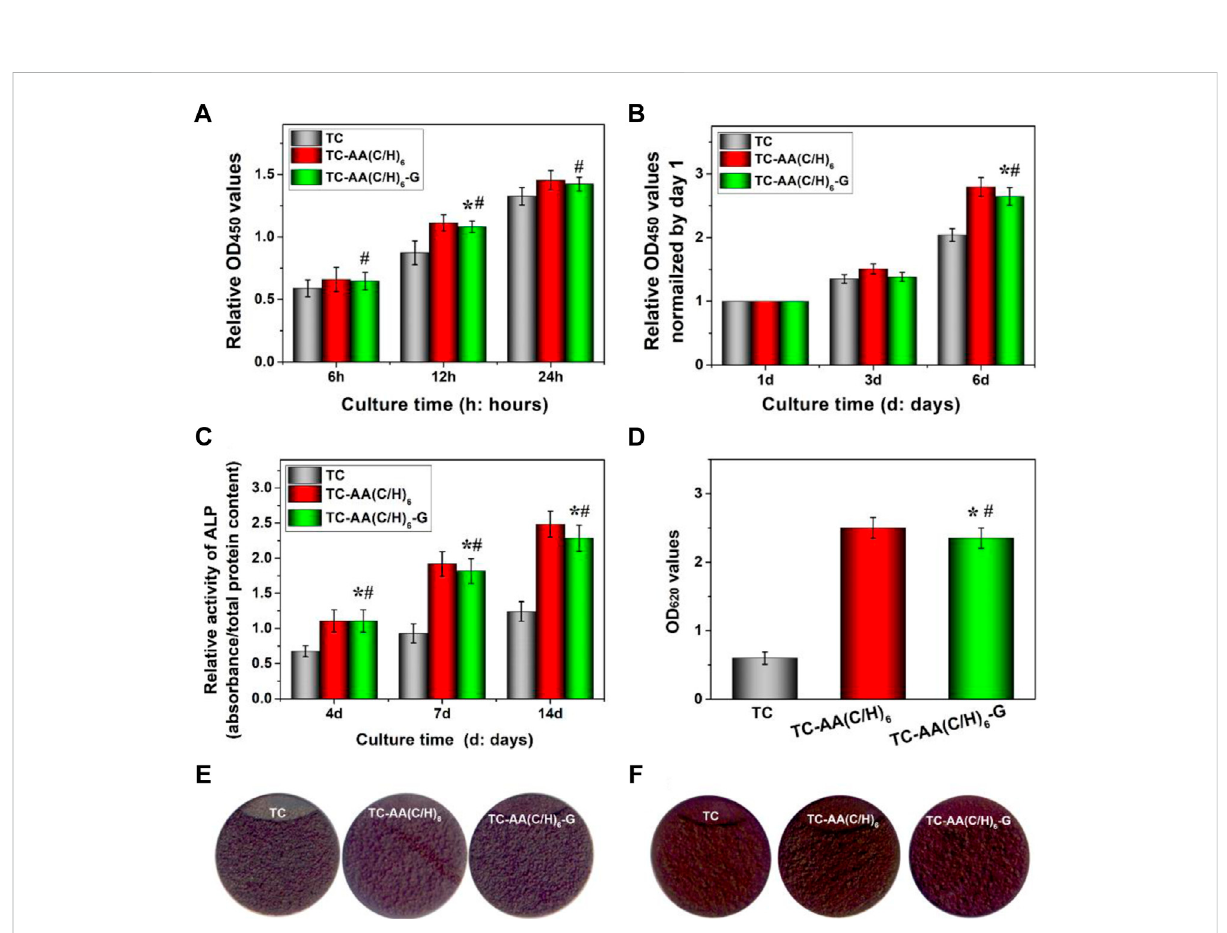
FIGURE 5 Cytocompatibility of TC, TC-AA(C/H) 6 and TC-AA(C/H) 6 -G. (A) Attachment of hMSCs on three different samples; (B) Proliferation of hMSCs on three different samples; (C) ALP activity was measured using the pNPP assay and normalized based on the protein content per specimen at days 4, 7 and 14; (D) Colorimetric quantitative analysis of the extracellular matrix mineralization on the samples after 21 days of incubation; (E) ALP staining was performed at day 14; (F) Alizarin red staining. * p < 0.05, there has signi fi cant difference between TC-AA(C/H) 6 -G and TC. # p > 0.05, there has no signi fi cant difference between TC-AA(C/H) 6 -G and TC-AA(C/H) 6